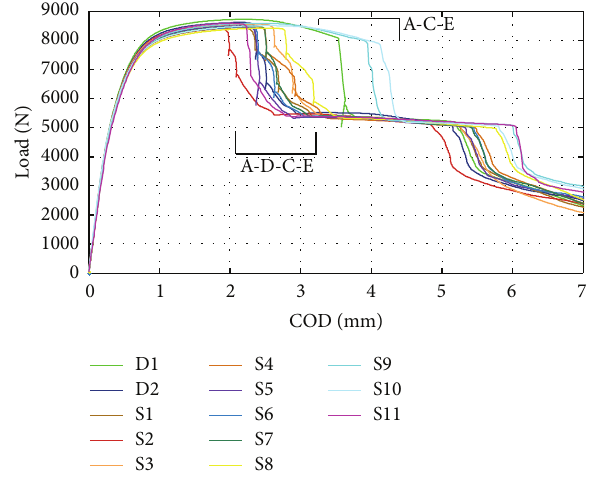
Figure 2: Load versus COD measurements for thirteen challenge specimens [4,